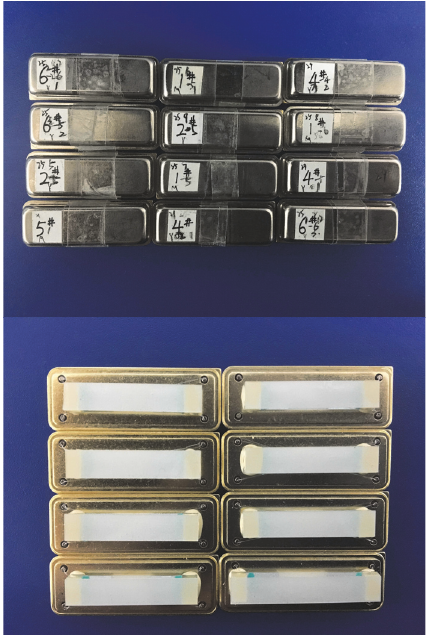
Figure 5: Physical maps of SAW based on a micro sensor.